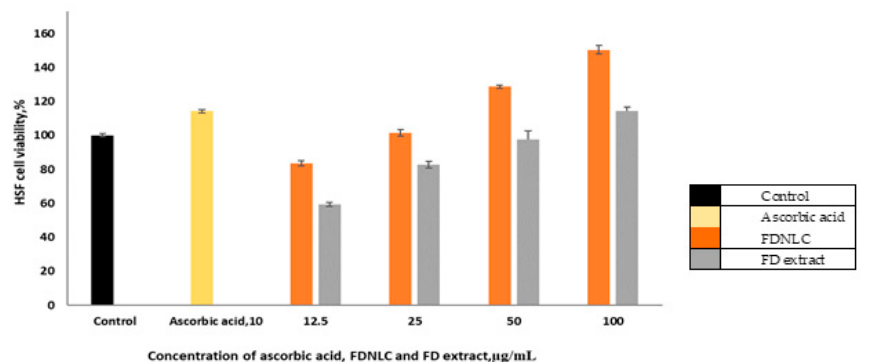
Figure 8. Cell viability of fibroblast cells (HSF 1184) cultured with increasing concentrations of FDNLC using the MTT assay. Data are presented as mean ± SD ( n = 3). Ascorbic acid, 10-ascorbic acid at 10 µ g / mL concentration. Control is the cell treated with DMEM only. * p < 0.05 as compared to FDNLC, indicate a statistically significant value.